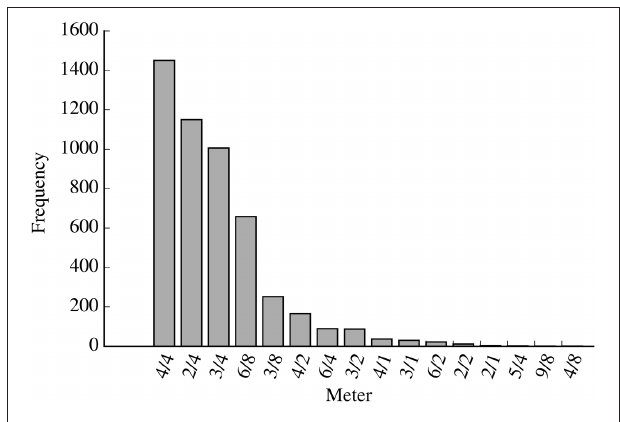
FIGURE 2 | Histogram showing the of the distribution of meters in the dataset of 4,966 German folksongs from the Essen folksong